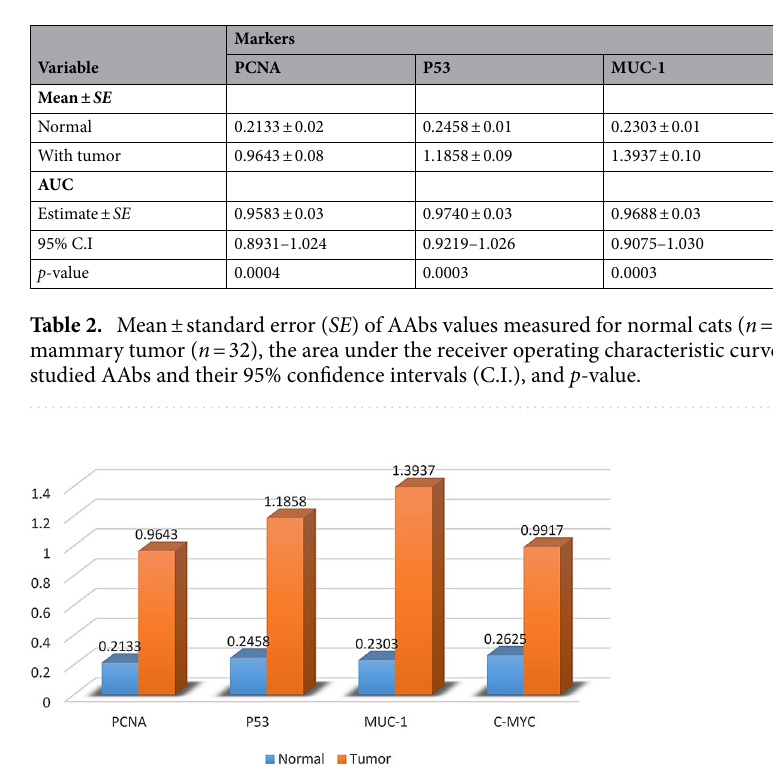
Figure 1. AAbs mean values measured for normal cats (n = 6, blue) and cats diagnosed with mammary tumor (n = 32,